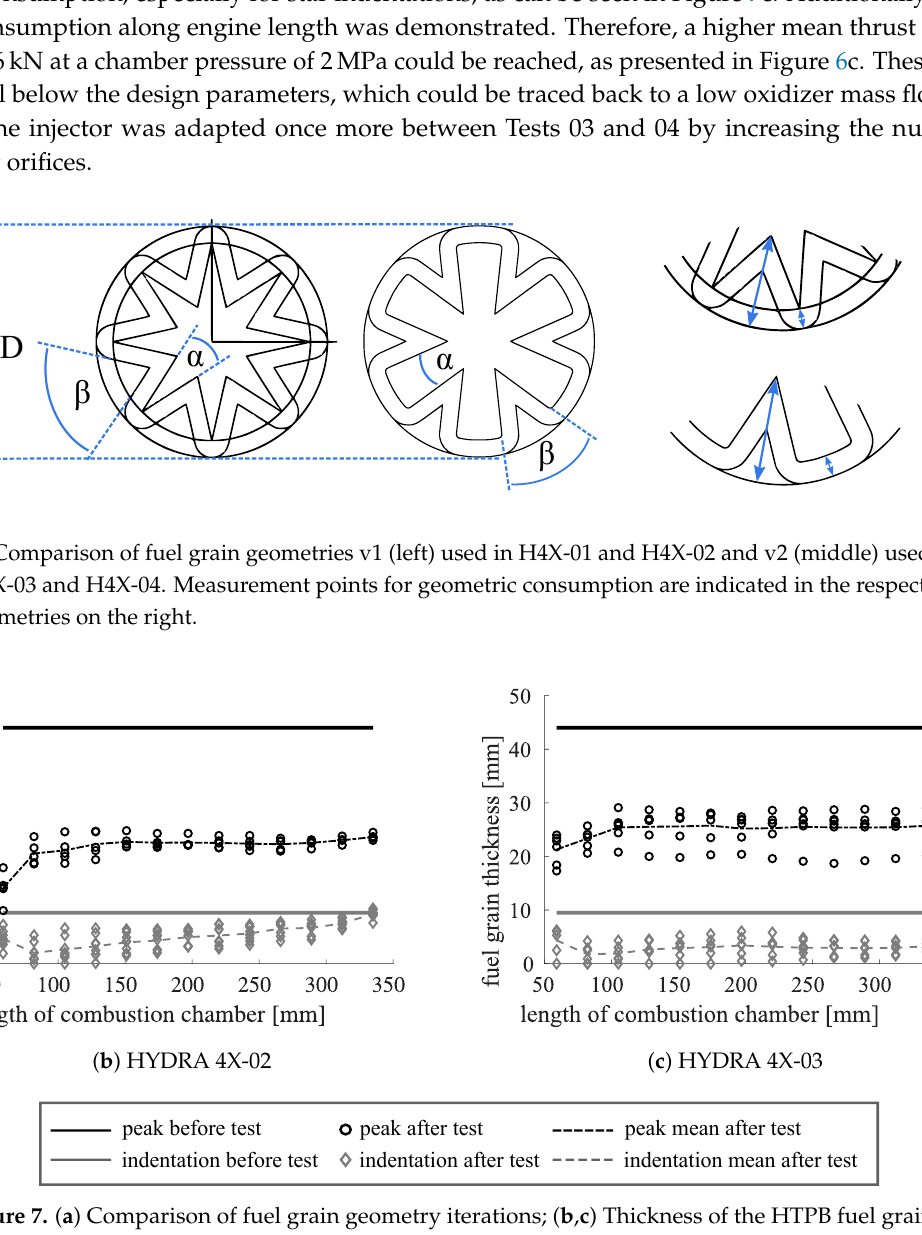
Figure 7. ( a ) Comparison of fuel grain geometry iterations; ( b , c ) Thickness of the HTPB fuel grain at star peaks in black and indentations. Distances were measured originating from the chamber wall. Symbols represent measurement points as indicated in ( a ), and lines resemble the corresponding mean